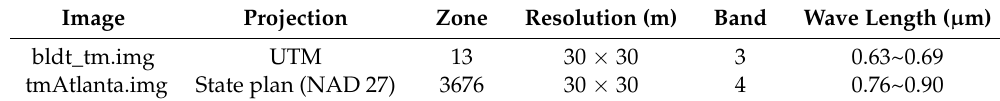
Figure 20. The raw image. ( a ) The first raw image. ( b ) The second raw image. Table 2. The information of two data sets